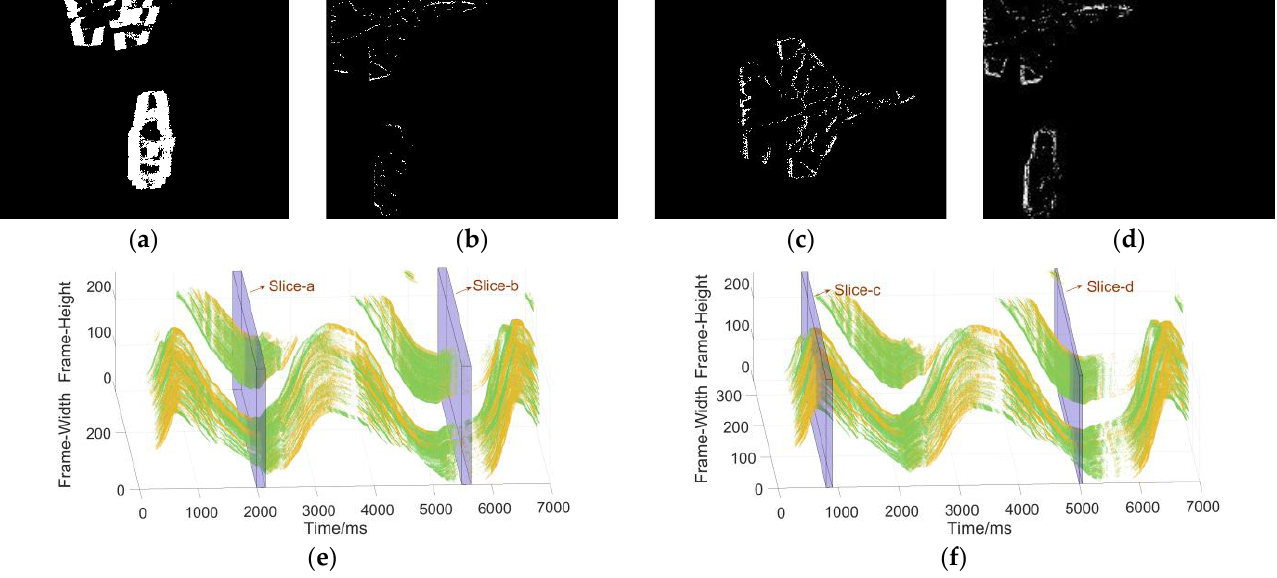
Figure 3. ( a , b ) are virtual frames constructed from slice-a and slice-b of ( e ), which are sliced by the